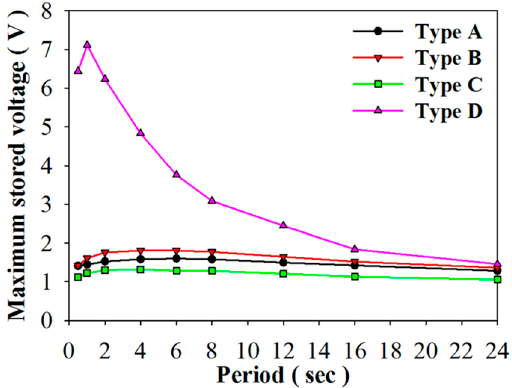
Figure 14. Relationship between the maximum stored voltage and period for using the PZT cells with various structures.